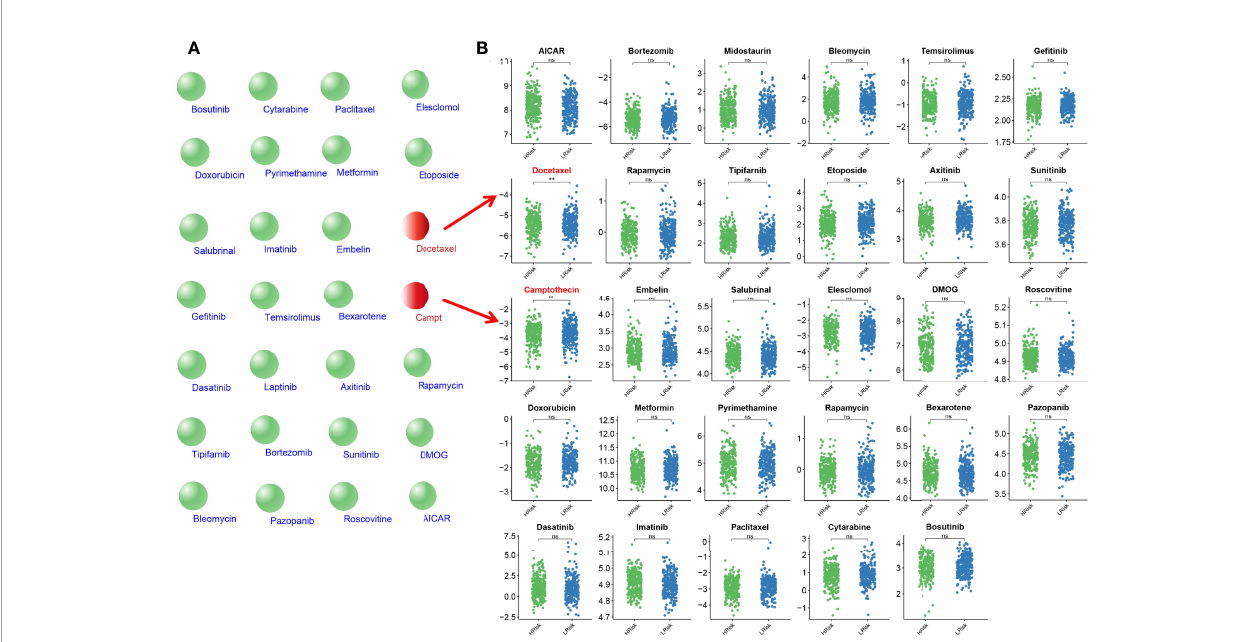
FIGURE 12 | Estimated drug sensitivity in LUAD patients with high and low HAGS risk. (A) The 28 common anticancer drugs may have therapeutic potential for LUAD patient. (B) The difference in the IC50s of 30 common antitumor drugs between the high- and low-risk groups was compared by using the Wilcoxon signed- rank test. **p < 0.01; ns, not signi fi